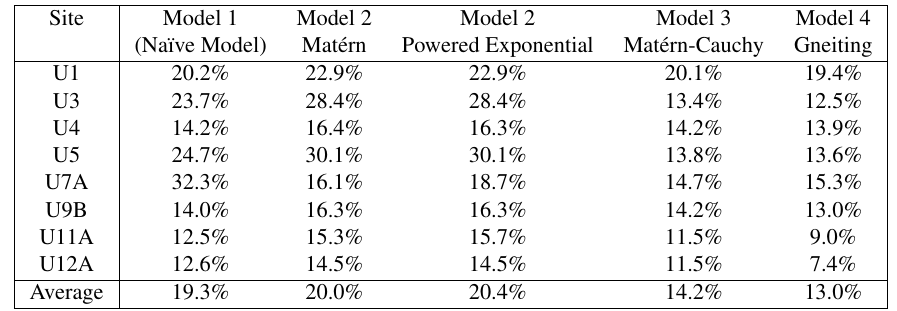
Table 5. PMPD for Models 1-4